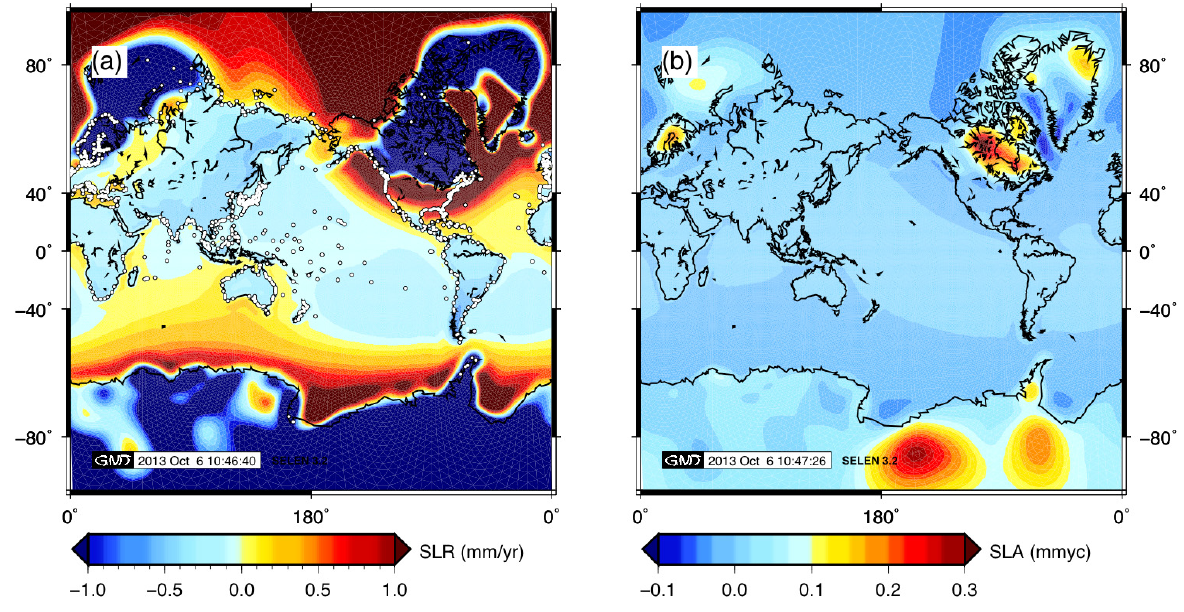
Figure 3. GIA sea-level fingerprints. GIA fingerprints for the rate of sea-level rise (a) and its time-derivative (sea-level acceleration) (b), computed at present time for model ICE-5G(VM2) [Peltier 2004] and obtained by code SELEN [Spada and Stocchi 2007, Spada et al. 2012]. In (a) the dots show the PSMSL tide gauges, and the actual rates in polar regions far exceed the range of the color table. Since relative sea-level is defined by the offset between the geoid height and the Earth’s solid surface [Milne and Mitrovica 1998], these fingerprints are also defined across the